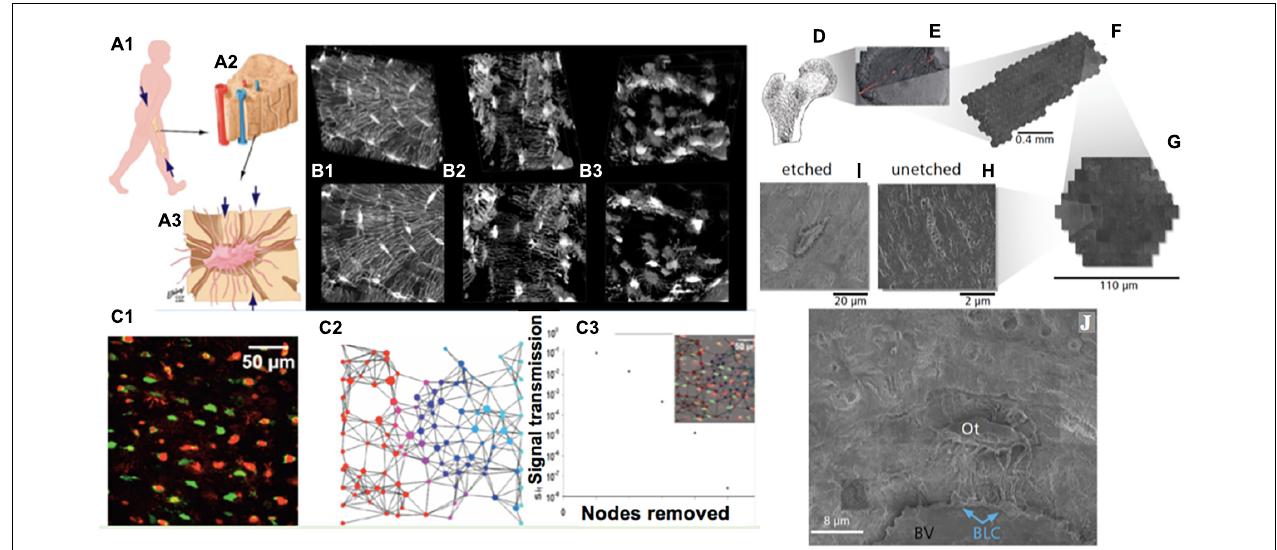
FIGURE 1 | Imaging cellular networks and environments across length scales, from nano to meso, using cross length scale imaging (multi-beam scanning electron microscopy) of the cellular inhabitants of the human femoral neck, i.e., osteocytes, as a case study. (A) Organism (A1) to tissue (A2) to cellular (osteocyte, A3 ) length scales demonstrating the most prevalent cellular inhabitants of bone, osteocytes. During development, cells manufacture the tissues comprising the femoral head and neck (proximal femur, A1,D ); the cellular inhabitants of bone, cartilage and other tissues model (during growth) and remodel (enabling adaptation) the respective tissues of their local environment through up- and down-regulation of structural protein transcription, and secretion into the extracellular matrix. (B) The cellular network of bone’s resident osteocytes changes throughout life, in health and disease ( B1 : healthy, B2,B3 : diseased). (B,C) The loss in network connectivity reflects the health status of the cells ( C1 , live and dead osteocytes visualized using an ethidium bromide assay) as well as the patency of the network ( C2 —stochastic network model with nodes representing cells , C3 —calculation of loss in information transfer with loss in network nodes ) ; loss of viable cells within the network results in loss in network connectivity and subsequent diminished information transfer capacity across and within the network. (D–J) mSEM imaging, combined with image stitching and Google Maps API geonavigation applications, enables high resolution imaging of inhabitant cells within tissues, as well navigation and analysis of single cells and their complex networks, seamlessly across length scales ( D, femoral head and neck; E, section through the femoral head created by stitching together of many images, comprising arrays; F , of hexagons; G , themselves made of arrays of electron beams). Rather than using single electron beams as in traditional electron microscopy, mSEM uses arrays of 61 and more beams (F,G) to capture large areas of tissue (mesoscale, E ) with nanoscale resolution (H–J) . Through inorganic and organic etching procedures adapted from atomic force microscopy, the third dimension of cellular networks may be captured (H,I) and the local and global environment of tissues’ cellular inhabitants (Ot, Osteocyte; BLC, Bone Lining Cell) can be explored within tissue contexts (BV, upper half of oval Blood Vessel, above which bony matrix is seen). Images adapted and used with permission ( A, Knothe Tate et al., 2010; B, Knothe Tate et al., 2002; C, Anderson et al., 2008; D–J, Knothe Tate et al., 2016c).